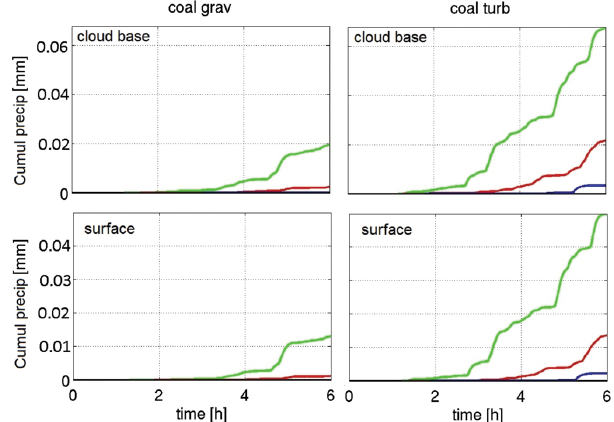
Fig. 14. Evolution of the cumulative precipitation (cumul precip) flux [mm] at the cloud base (upper panels) and at the surface (bot- tom panels) for gravitational (left) and turbulent (right) collection kernels. Green, red and blue lines represent evolutions for N 30, N 60, and N 120 simulations, respectively.